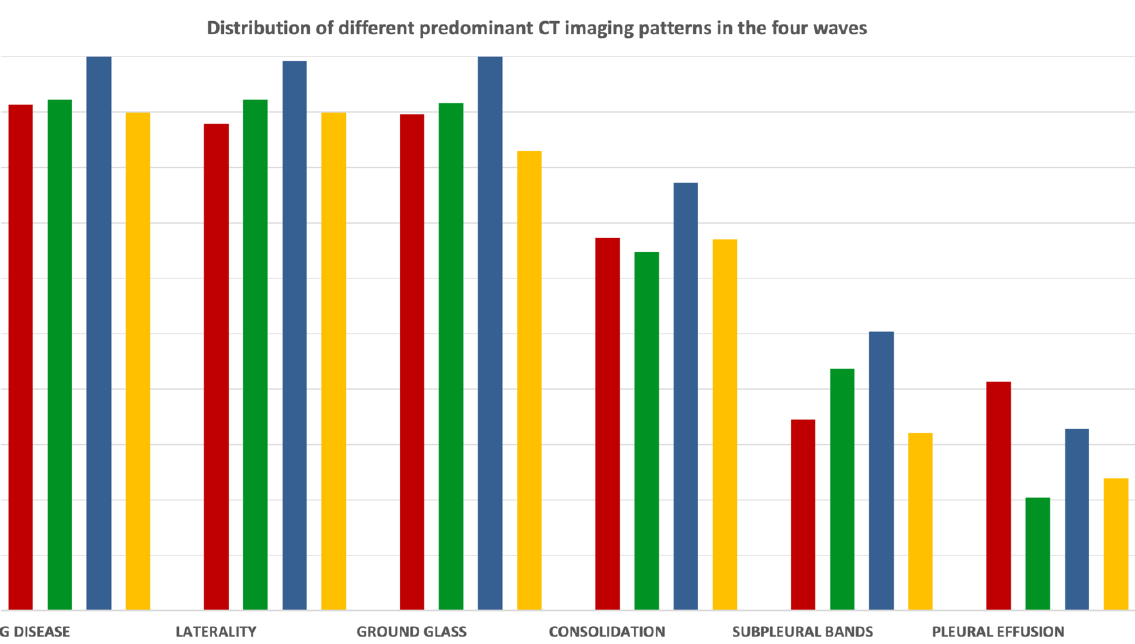
Figure 2. Axial images of different evaluated patterns of COVID-19 (each marked with arrow keys): ( A ) bilateral ground glass (GGOs); ( B ) consolidation; ( C ) subpleural bands; ( D ) pleural effusion.